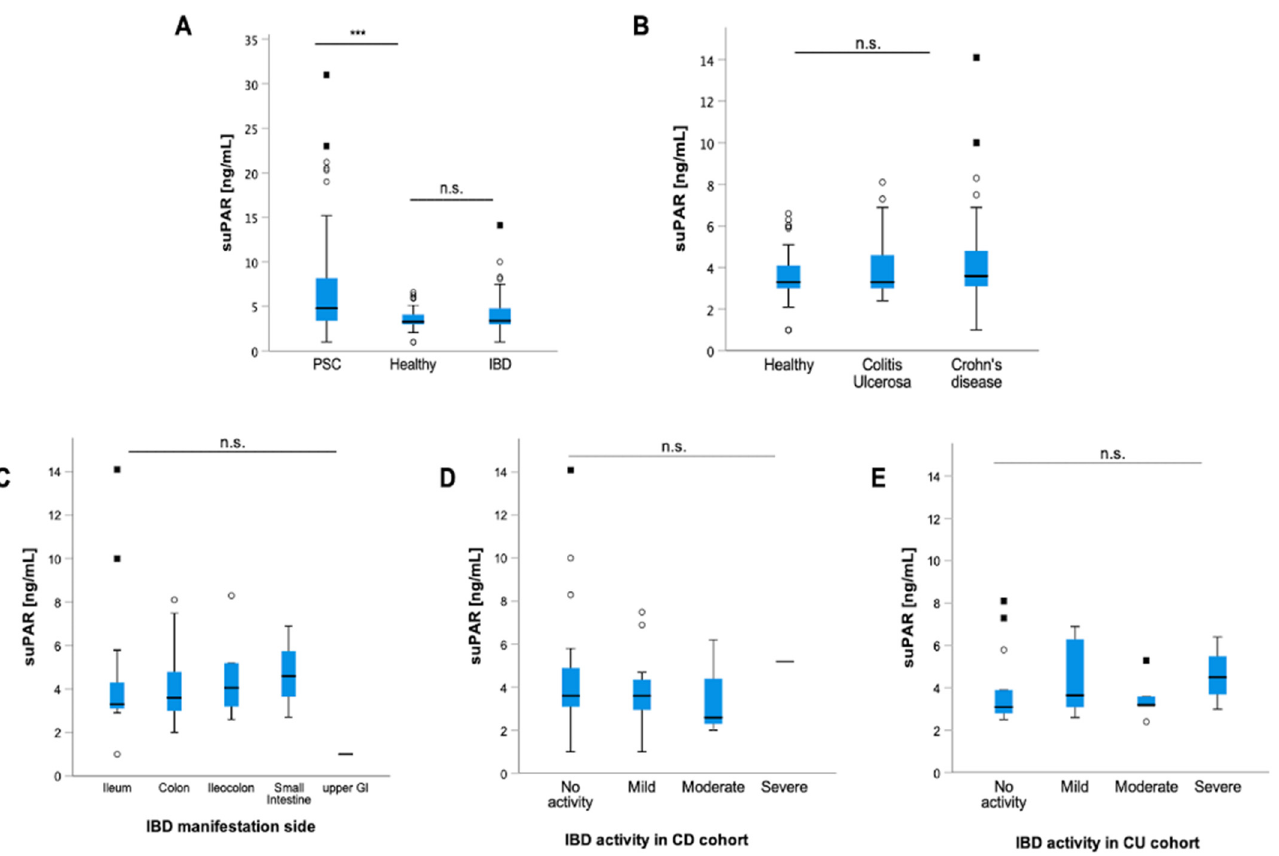
Figure 4. suPAR levels are not increased in patients with inflammatory bowel disease. Compared to healthy controls, soluble urokinase-type plasminogen activator receptor (suPAR) levels were elevated in patients with PSC ( p < 0.001), but not in patients with inflammatory bowel disease (IBD) ( A ). Moreover, suPAR levels were independent of the presence of colitis ulcerosa (CU) and Crohn’s disease (CD) ( B ). suPAR levels did not differ depending on the IBD manifestation side ( C ), and they did not reflect the disease activity in patients with CU ( D ) and CD, respectively ( E ). Box plots are displayed, where the bold line indicates the median per group and the edges of the box are the first and third quartiles. The horizontal lines show minimum and maximum values of calculated nonoutlier values. The dots represent calculated outliners. Soluble urokinase-type plasminogen activator receptor (suPAR). Colitis ulcerosa (CU) and Crohn’s disease (CD). (*** p < 0.001).